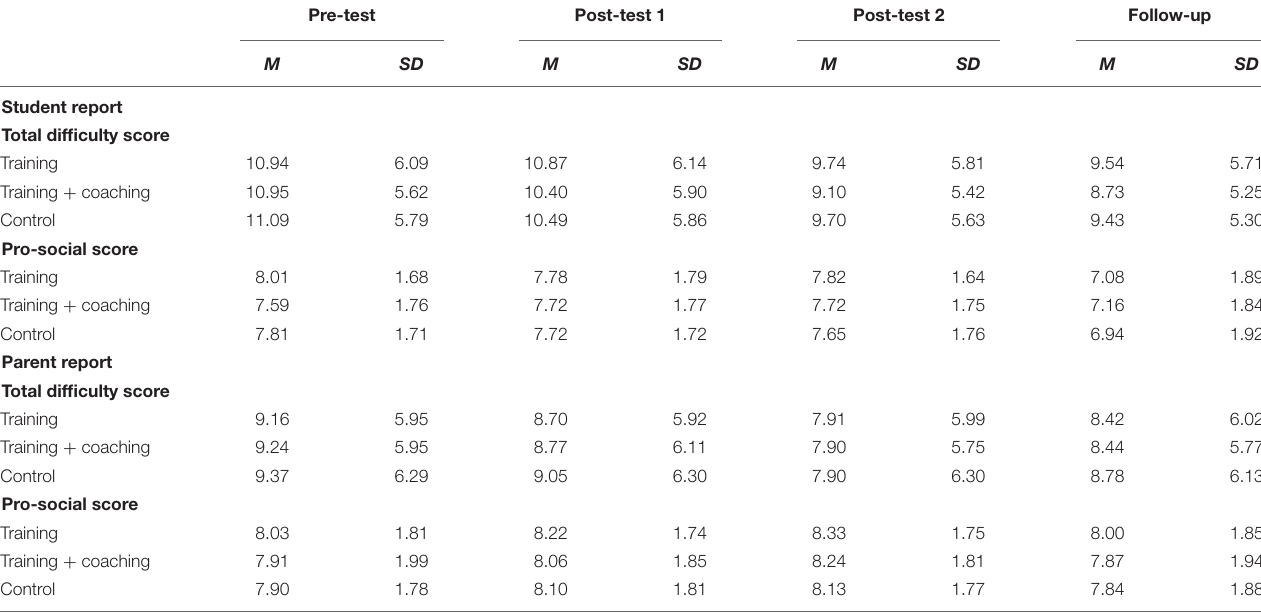
TABLE 3 | Adjusted means and standard deviations for the student-reported and parent-reported Strengths and Difficulties Questionnaire.